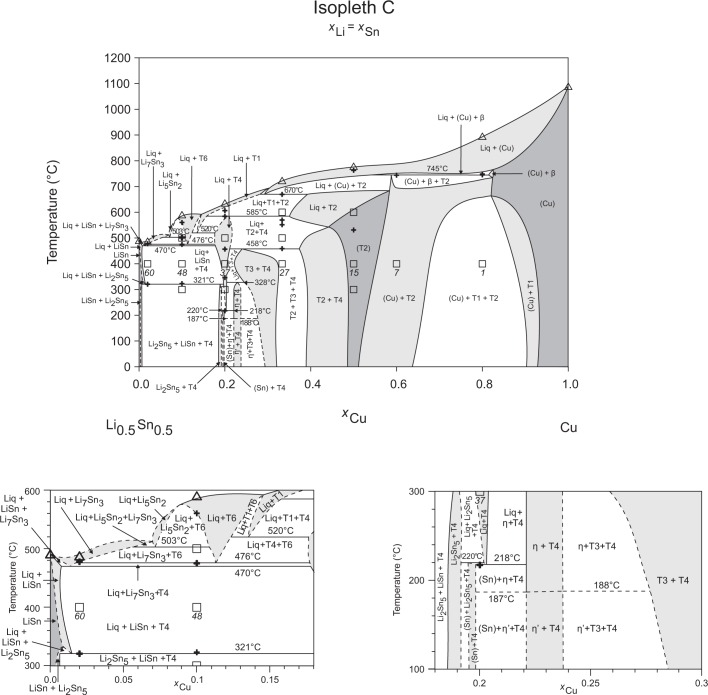
Isopleth C including both sections from xCu = 0–0.18 / T = 300–600°C and xCu = 0.18–0.30 / T = 100–300°C.